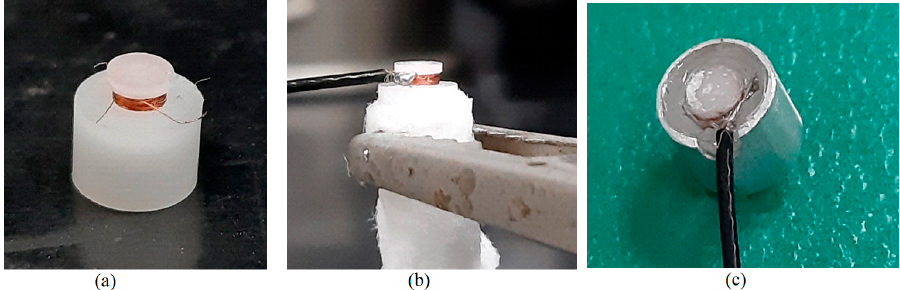
Figure 7. Photographs of the coil winding structure and the sensor assembly process: ( a ) coil winding, ( b ) wire connection, and ( c ) complete sensor assembly. ( b ) wire connection, and ( c ) complete sensor assembly.